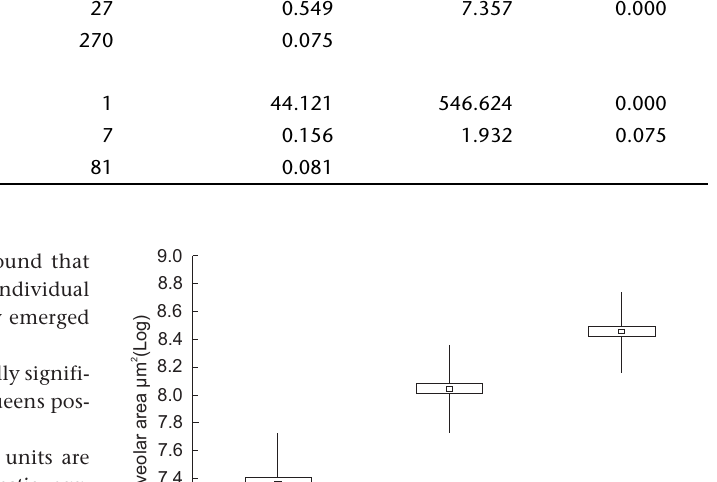
Table II. Variance analysis (ANOVA) of the size of cephalic salivary glands of S. postica workers (III) and queens (IV). Note the significatly different p value (p (cid:2) 0.05) among workers and between virgin and egg-laying queens. Significance p (cid:2) 0.05. Source of variation Sum of squares Degrees of Freedom Mean square Mean square ratio p